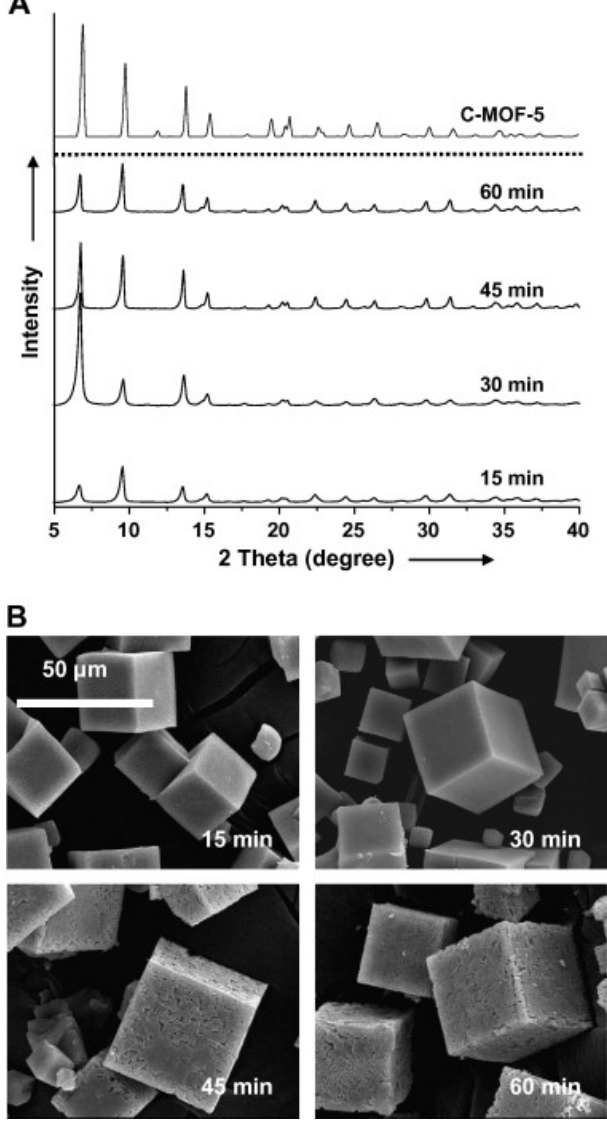
Figure 3. XRD and SEM images of MMOF-5 samples: microwave power was supplied at 600W [72]. Figure 3. ( A ) XRD and ( B ) SEM images of MMOF-5 samples: microwave power was supplied at Reprinted with permission from ref. [72]. Copyright 2008 Elsevier. 600 W [72]. Reprinted with permission from Ref. [72]. Copyright 2008